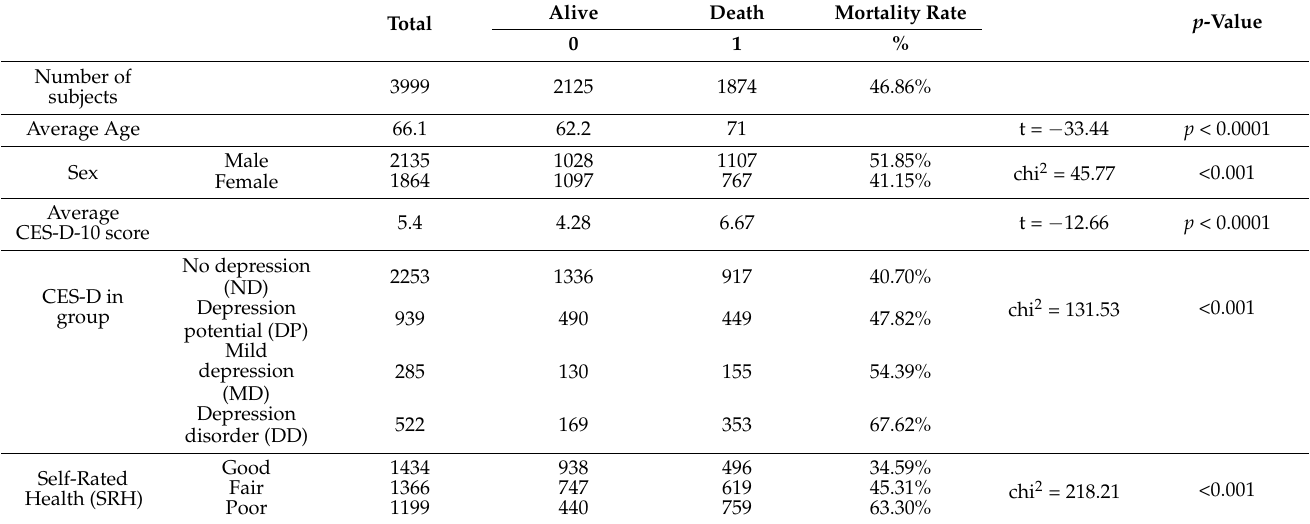
Table 2. Characteristics by